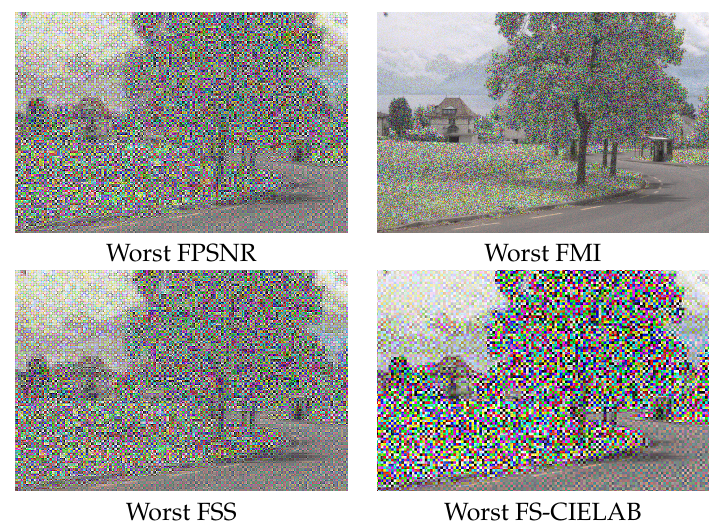
Figure 5. Best DWT fusion results according with the evaluated metrics.